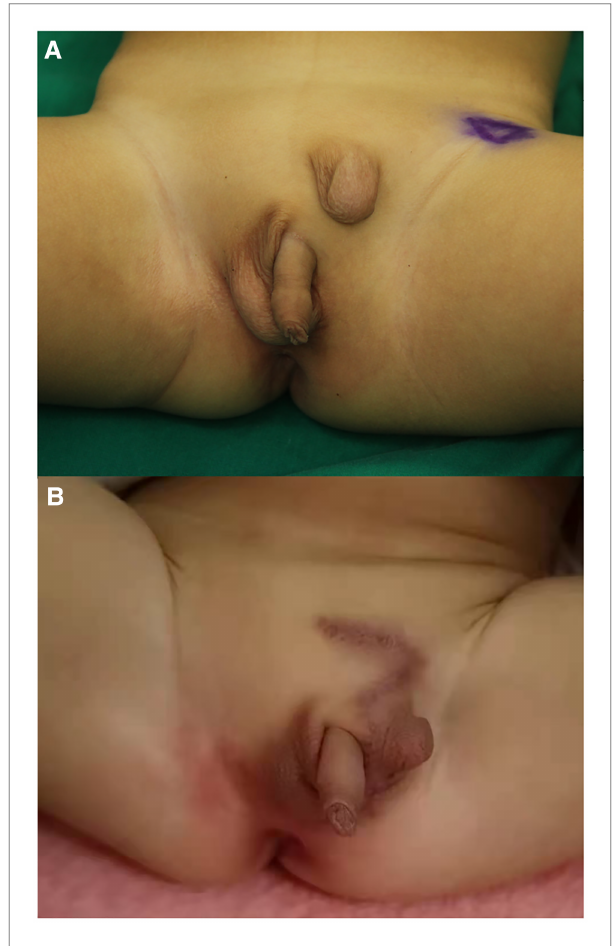
FIGURE 1 Preoperative and postoperative appearances of ES. ( A ) Preoperative. ( B ) Postoperative. ES, ectopic